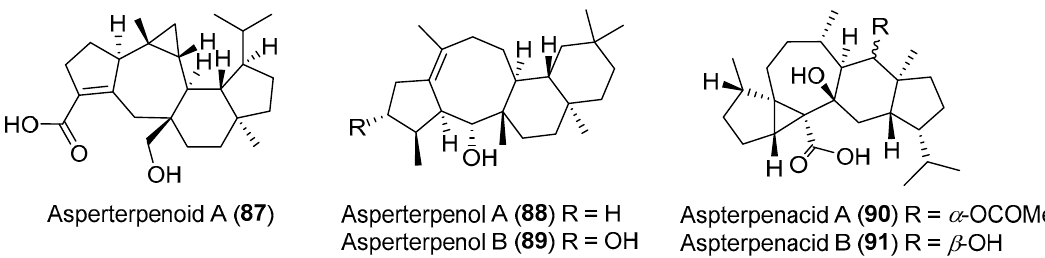
Figure 15. Structures of sesterterpenoids 87 – 91 .